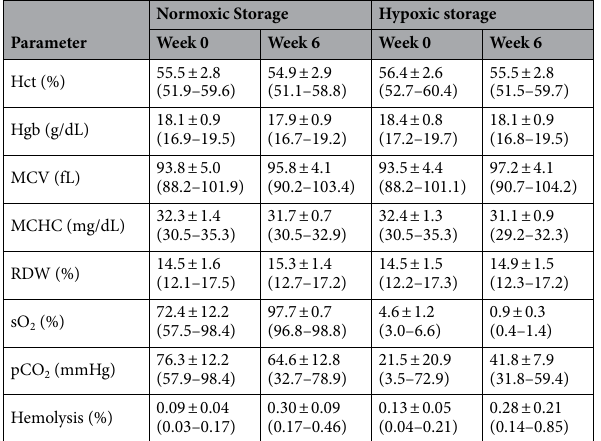
Table 1. Hematological parameters for RBCs stored under standard (normoxic) and hypoxic conditions at the beginning (week 0) and end (week 6) of hypothermic storage (n = 9). Values shown are mean ± standard deviation